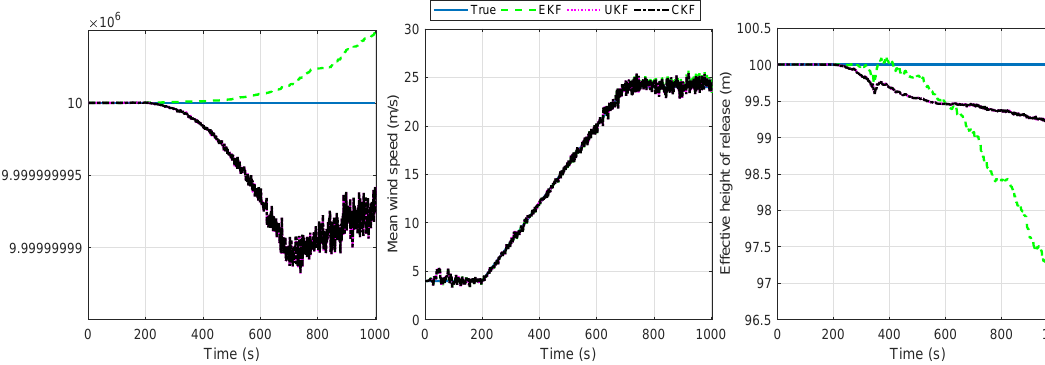
Figure 5. True and estimated release rate, wind speed, and height of release for variation in wind